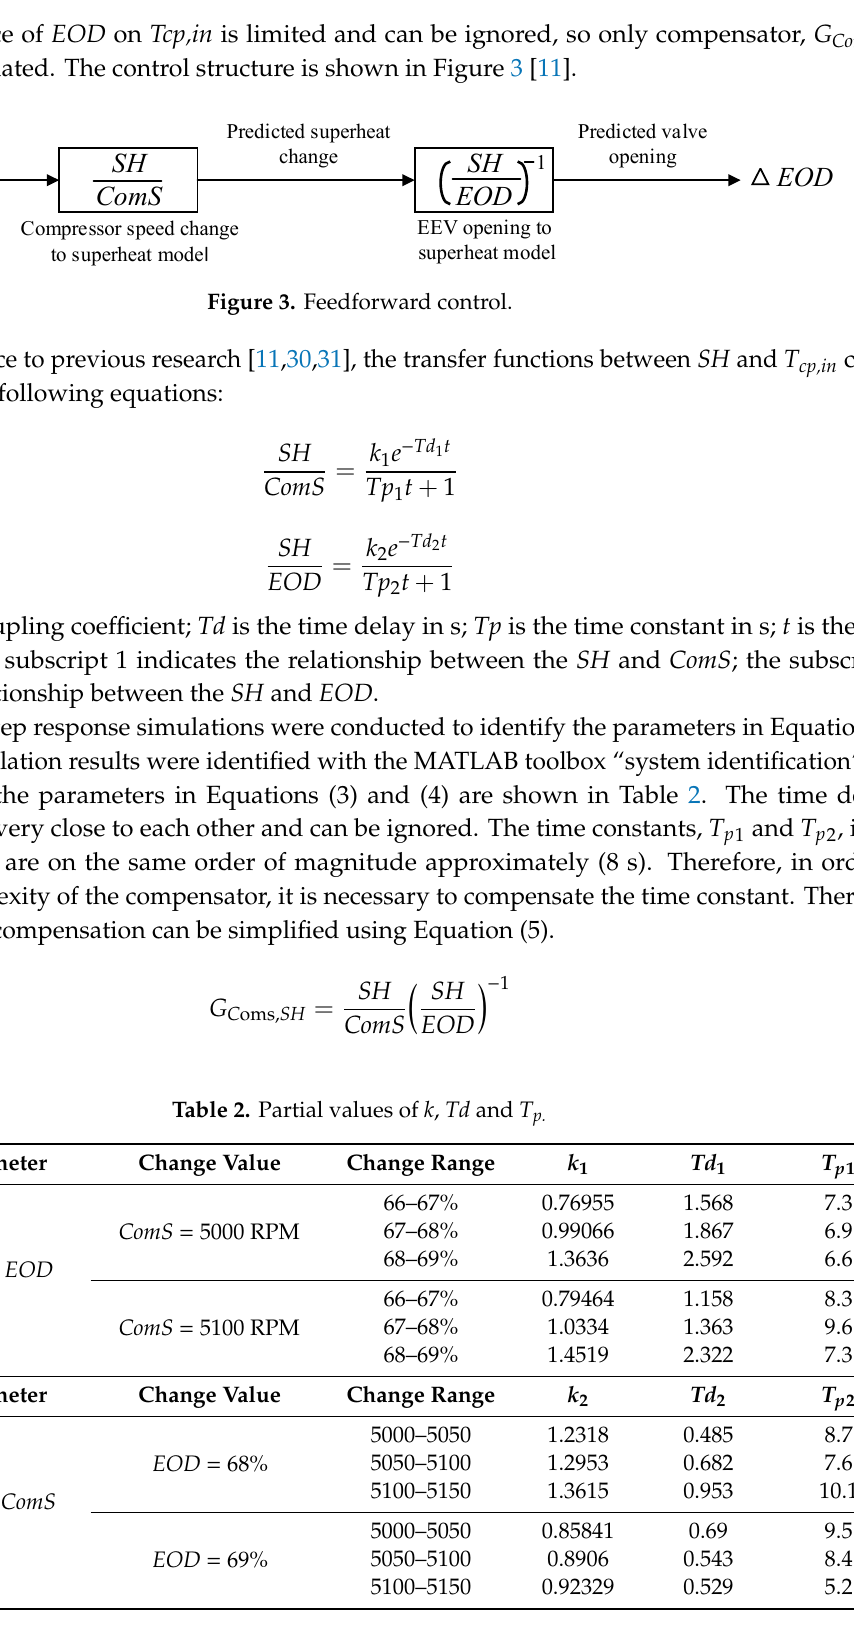
Figure 2. Coupled control strategy of SH and T cp,in.